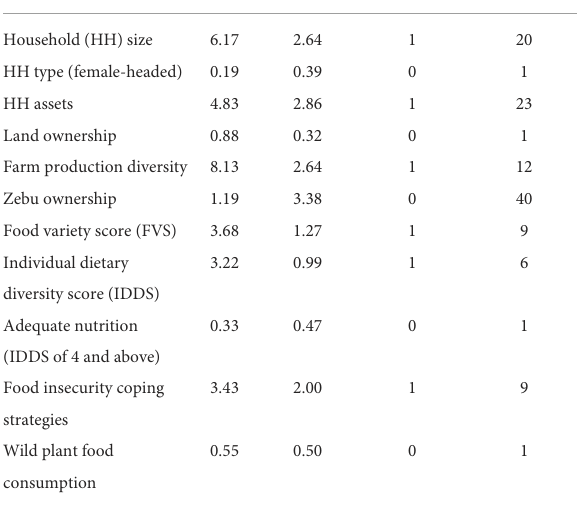
TABLE 2 Summary of descriptive